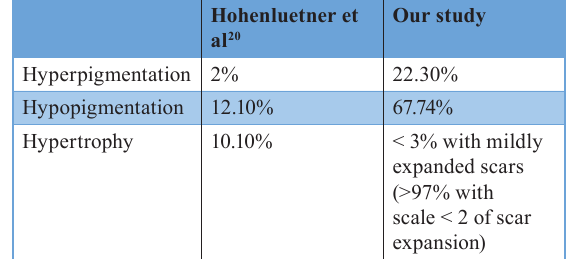
Table 8. Comparison of scar qualities between Hohenleutner et al's study and our study.